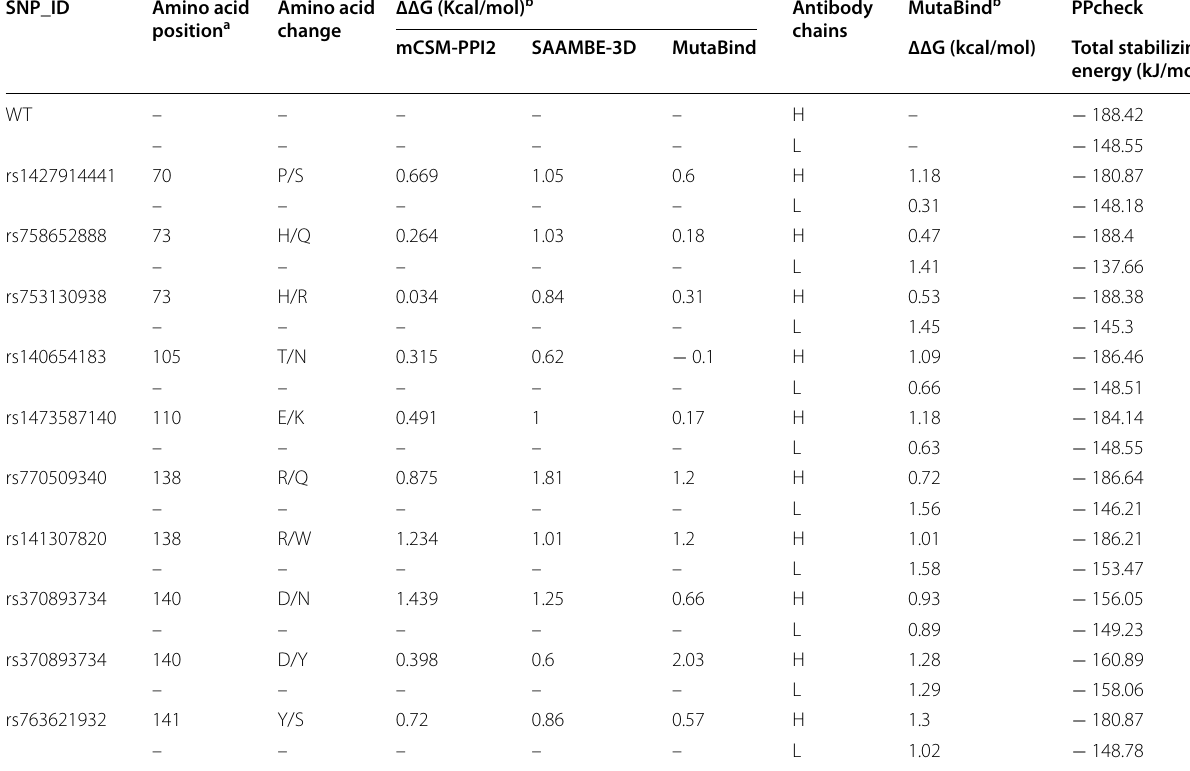
Table 5 Effects of epitopic missense variants on TNFA-infliximab interaction